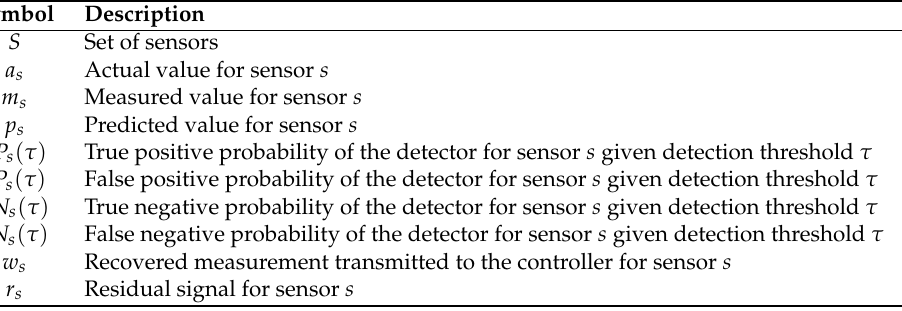
Table 1. List of Symbols.